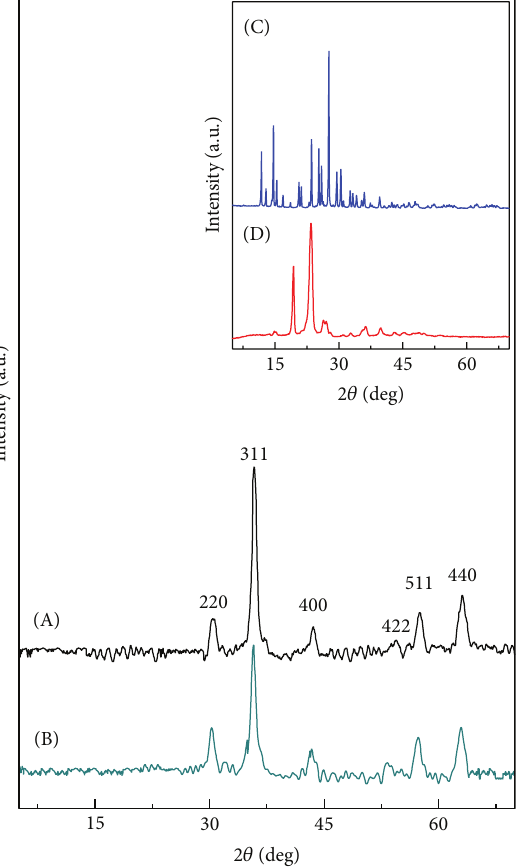
Figure1:XRDpatternsofFNPs(A)andFPEGMP-2nanocomposite (B). The inset shows the XRD patterns of pure MP (C) and pure PEG